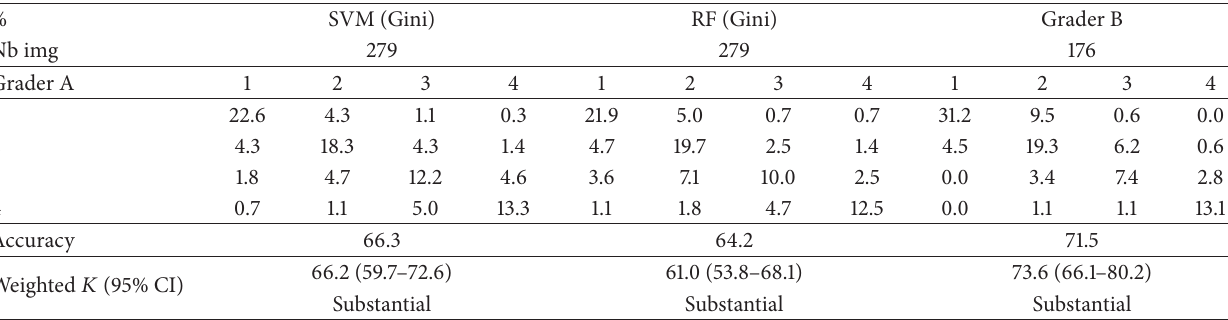
Table 6: Confusion matrix in percentage for grading in two steps ( {1 & 2} versus {3} versus {4} and then {1} versus {2} ).